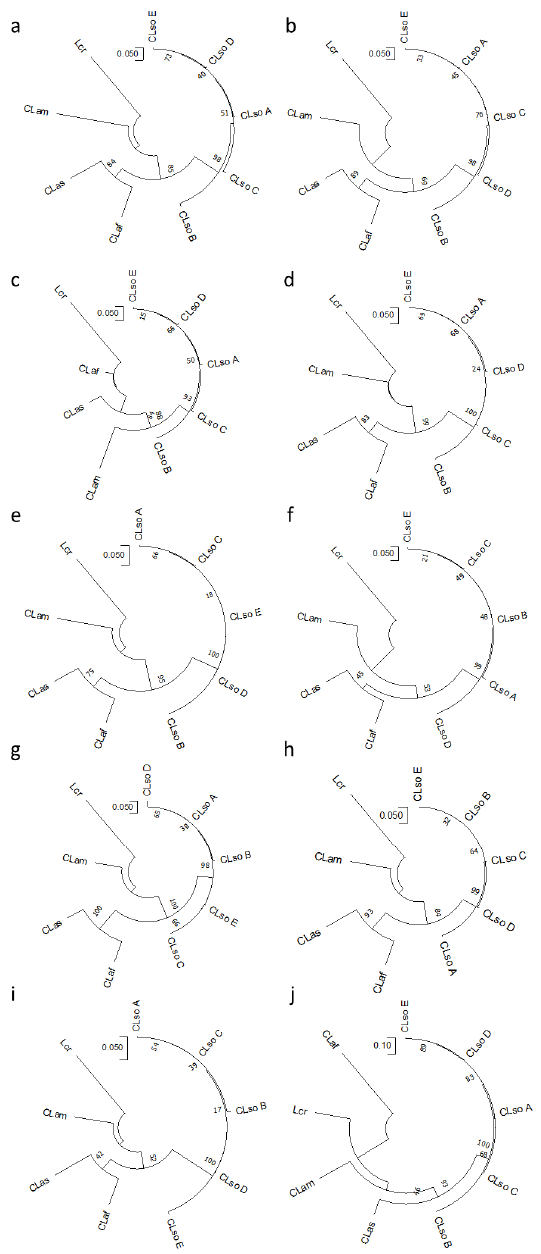
Figure 4. Phylogenetic tree of representative isolates of CLso, CLas, CLaf, and Lcr based on partial sequence of adk ( a ), dnaG ( b ), fumC ( c ), grpE ( d ), icdA ( e ), metG ( f ), mutS ( g ), purA ( h ), recA ( i ) and gyrB ( j ). Analysis was performed by using the Maximum Likelihood method and the Tamura-Nei model [28]. Bootstrap values (1000 replications) are shown at the branch